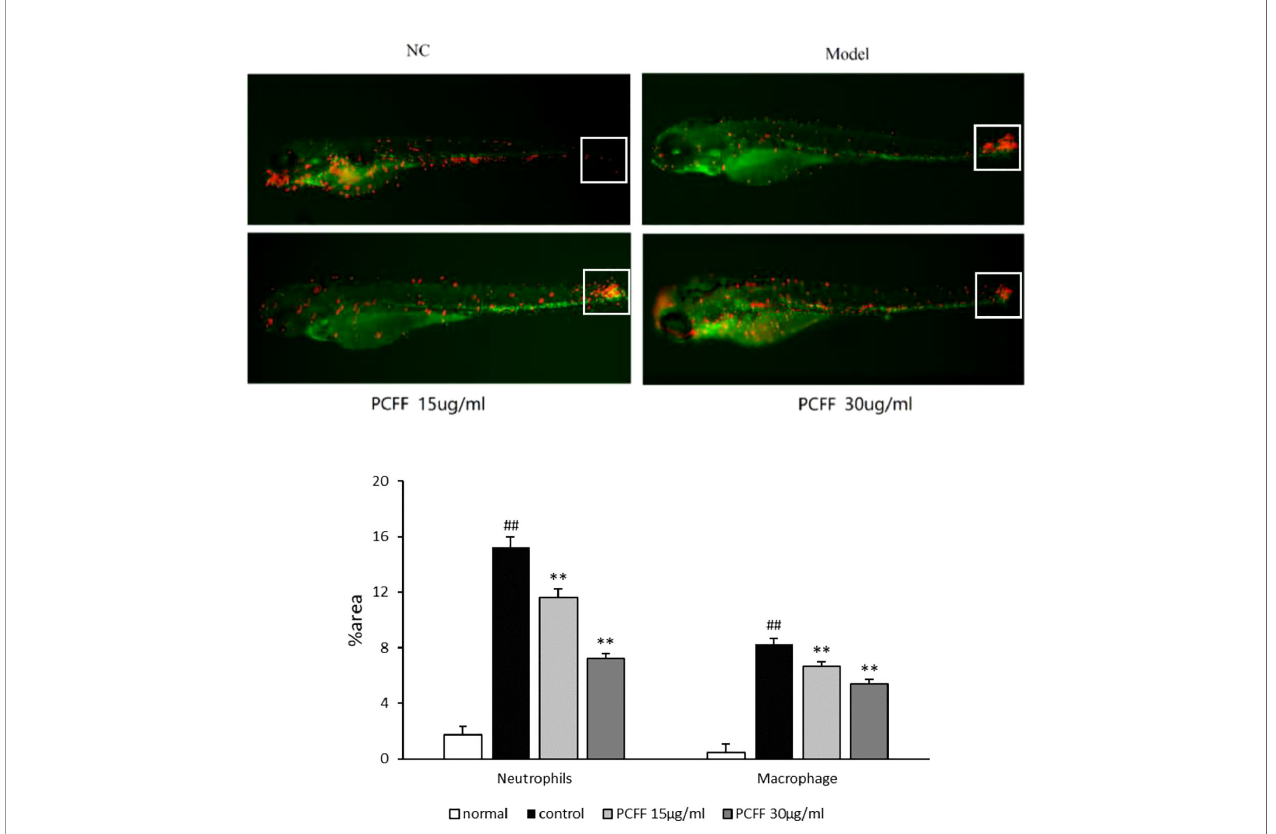
FIGURE 3 | Inhibitory effect of PCFF on migration of zebra fi sh macrophages and neutrophils. Each value indicates the mean ± SD from three independent experiments. Compared with normal group, ## P < 0.01; compared with control group, **P < 0.01. NC group untreated; Model group cut tail; PCFF group added different dose PCFF after tail